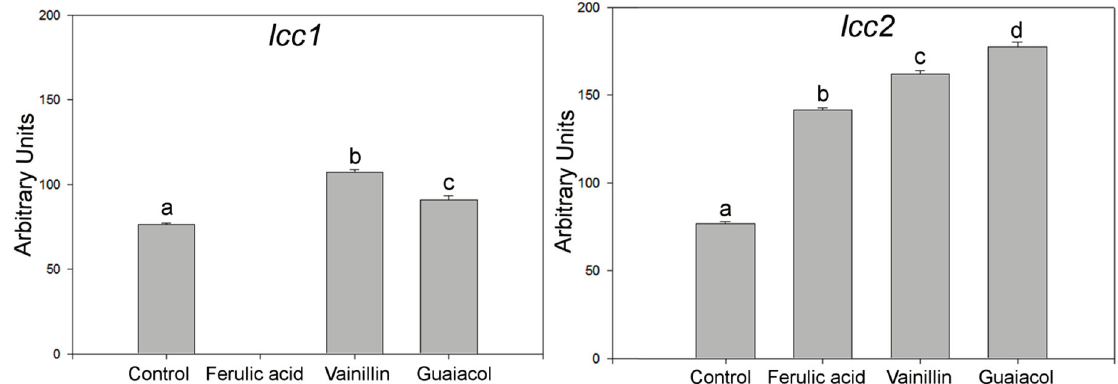
Figure 2. lcc1 and lcc2 transcript levels as determined by the densitometric quantitation of RT-PCR products. The relative rates of lcc1 and lcc2 transcription following the addition of different phenolic compounds to eight-day-old T. hirsuta Bm-2 cultures are presented in arbitrary units (AU). Results were represented as means ± standard deviation of three parallel measurements ( n = 3). Different letters represent significant differences at p <